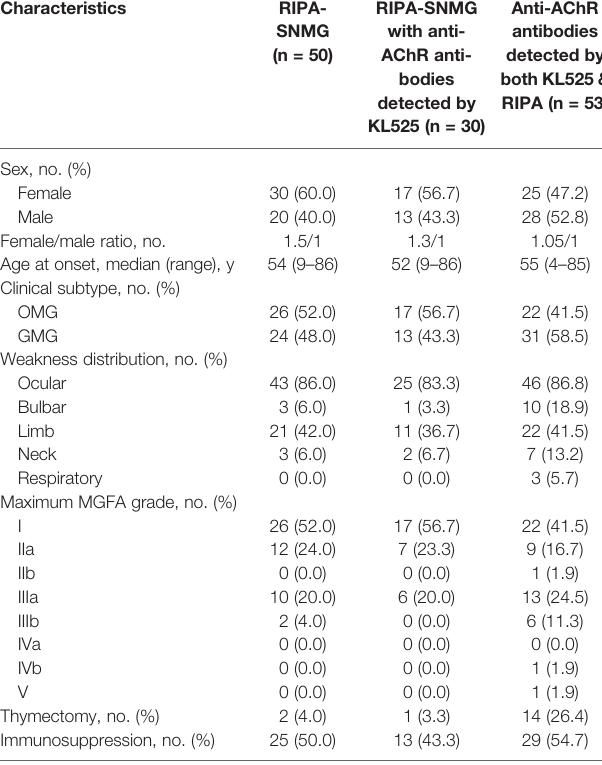
AChR, nicotinic acetylcholine receptor; GMG, generalized myasthenia gravis; MG, myasthenia gravis; MGFA, Myasthenia Gravis Foundation of America; OMG, ocular myasthenia gravis; SNMG, seronegative myasthenia gravis.